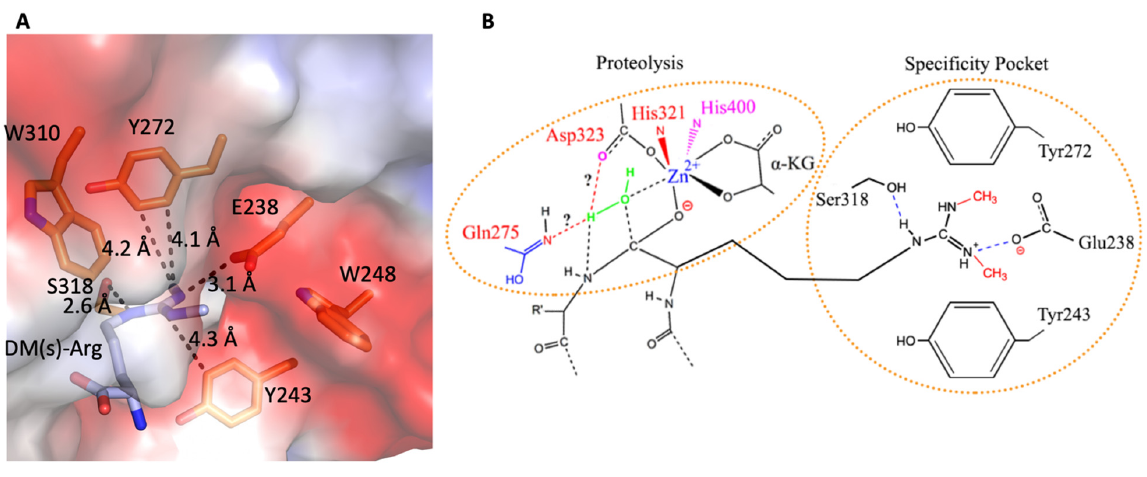
Figure 9. The endopeptidase and carboxy-exopeptidase activities of c-JMJD5 and c-JMJD7 on syn- thesized histone tails. ( A ). c-JMJD5 and mutant c-JMJD5 cleavage on H3R2me2s. The top portion is the sequence of the H3R2me2s peptide with symmetric di-methylation on R2 with MW 2,749.47Da. After cleavage, a major band of MW 2,494.3 (peak A) is the product of peptide with the first two residues missing. ( B ). c-JMJD7 generated a similar profile [23].